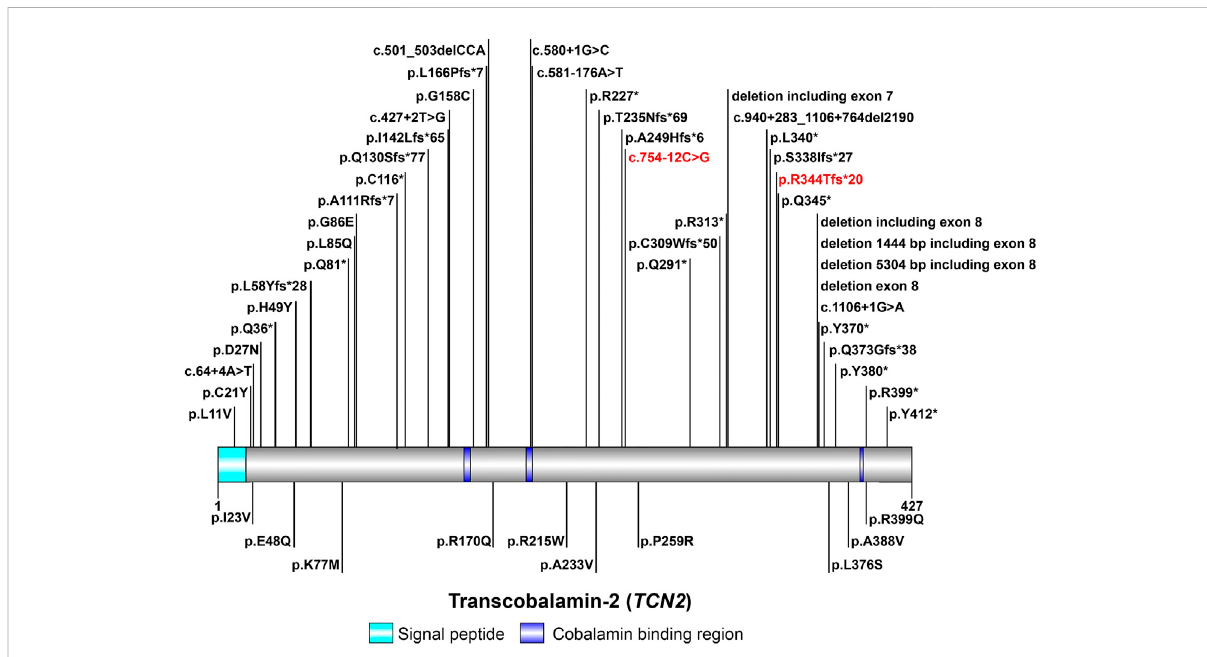
FIGURE 2 The spectrum landscape of mutations in TCN2 gene. A total of 48 mutations and polymorphisms of TCN2 gene were reported in HGMD. Disease-causing mutations (DMs) are marked on the top. Other non-DMs and polymorphisms are marked in the bottom. Two variants identi fi ed in this study are highlighted in